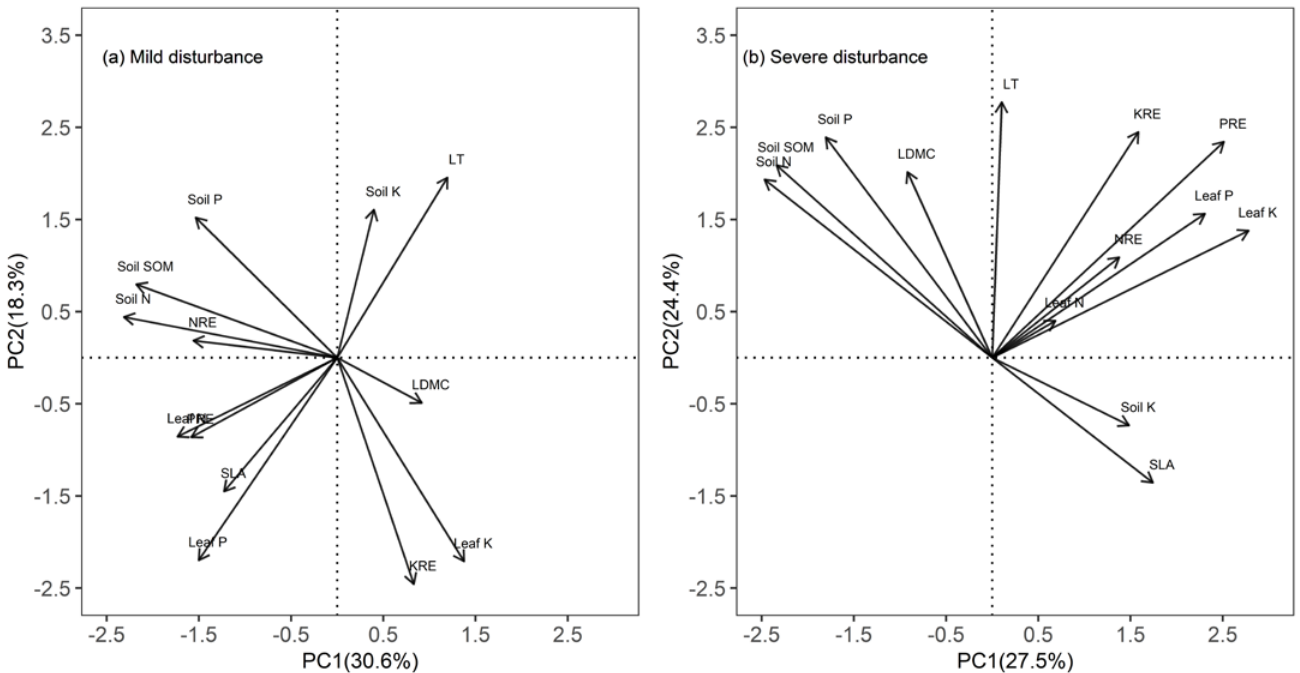
Figure 3. Principal component analysis (PCA) of nutrient resorption efficiencies, green leaf nutrient contents, soil nutrients, and leaf traits under the mild ( a ) and severe ( b ) disturbances in the Phoebe bournei forest. Leaf N: green leaf nitrogen content. Leaf P: green leaf phosphorus content. Leaf K: green